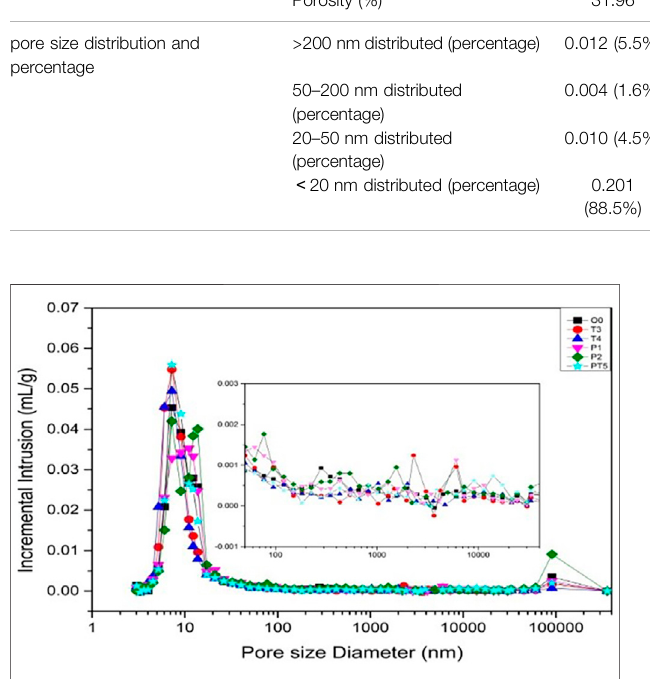
FIGURE10| PVA fi breandCNT-strengthenedgeopolymer28-daypore size distribution map.